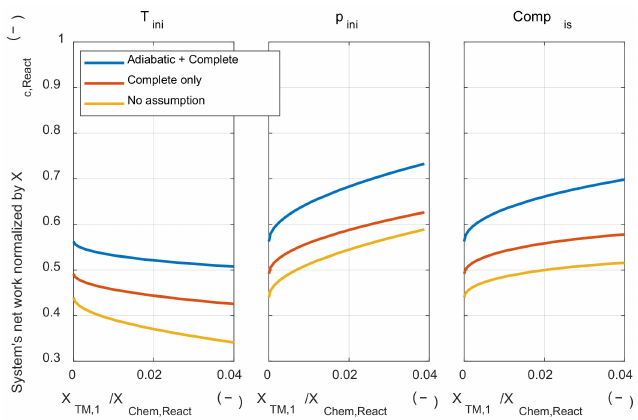
Figure A2. The system’s net work under various initial thermodynamic states and relaxed major assumptions